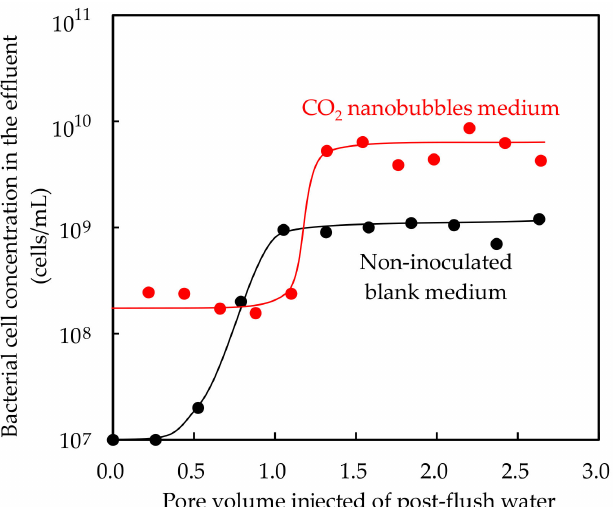
Figure 10. The temporal changes in the bacterial cell numbers in the effluent collected during the post-flush water